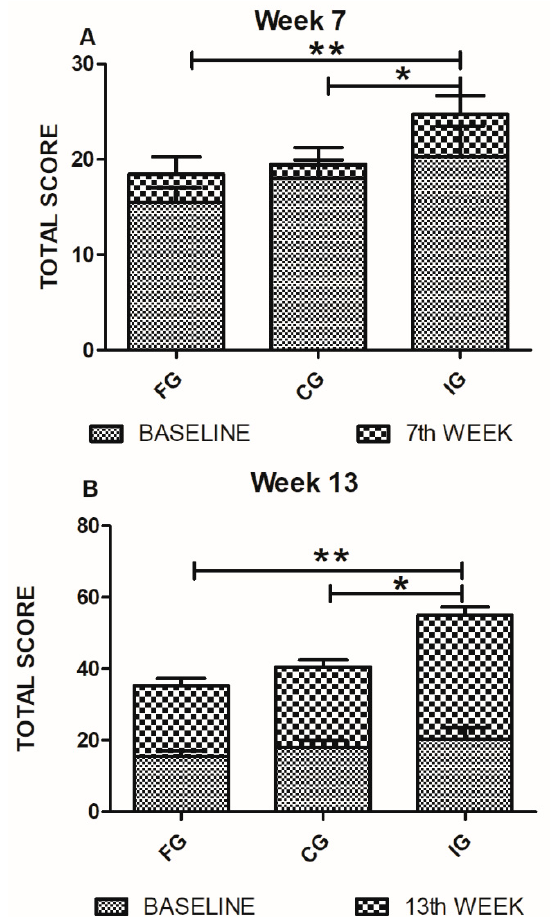
Figure 4. GMFE (walking) evaluations of FG, CG, and IG. ( A ) On the seventh week of evaluation, walking parameters showed a significant improvement in IG-patients. Analysis by the Mann Whitney U test. * p = 0.03 ** p = 0.01. ( B ) Walking evaluations on the 13th week showed a significant improvement of IG-patients compared with those of FG and CG. Analysis was performed using the Mann Whitney U test, * p = 0.001 ** p = 0.0003. Bars represent mean ± SD of 10 patients. Baseline values are also shown.